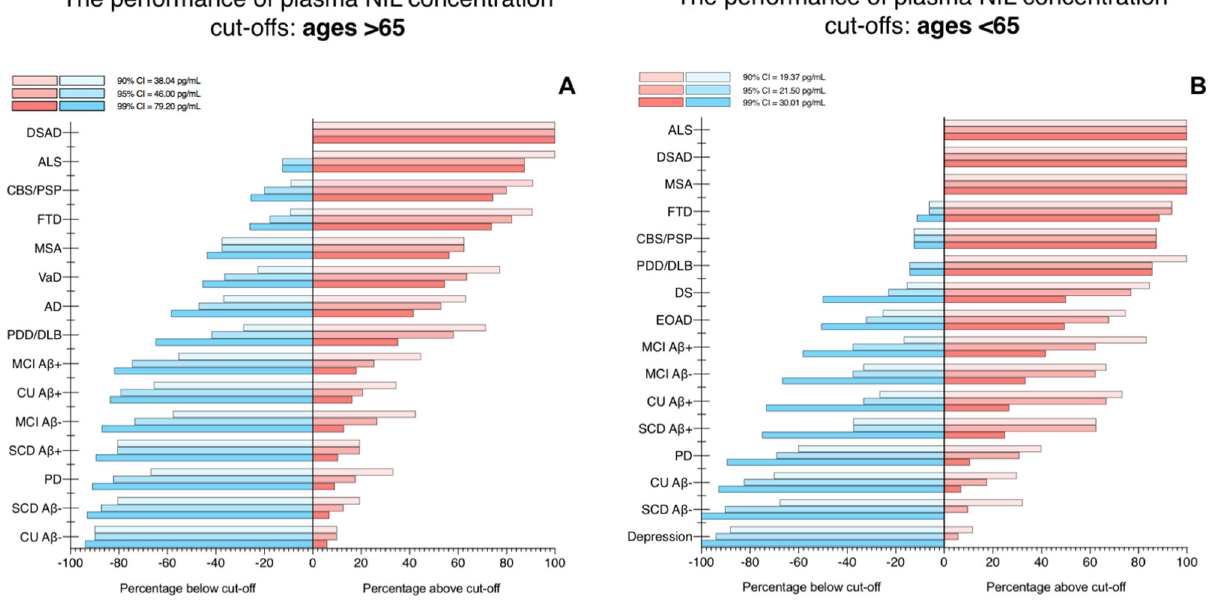
Fig. 6 The performance of plasma NfL concentration cutoffs to identify neurodegenerative disorders in >65 and <65 years. The performance of plasma neuro fi lament light (NfL) concentration cutoffs to identify neurodegenerative disorders in >65 ( A ) and <65 ( B ). The KCL and Lund cohorts are combined for this analysis. AD Alzheimer ’ s disease, ALS amyotrophic lateral sclerosis, CBS corticobasal syndrome, DLB dementia with Lewy bodies, DS Down syndrome, DSAD Down syndrome Alzheimer ’ s disease, EOAD early-onset Alzheimer ’ s disease, FTD frontotemporal dementia. MCI mild cognitive impairment, MSA multiple system atrophy, PD Parkinson ’ s disease, PDD Parkinson ’ s disease dementia, PSP progressive supranuclear palsy, SCD subjective cognitive decline, VaD vascular